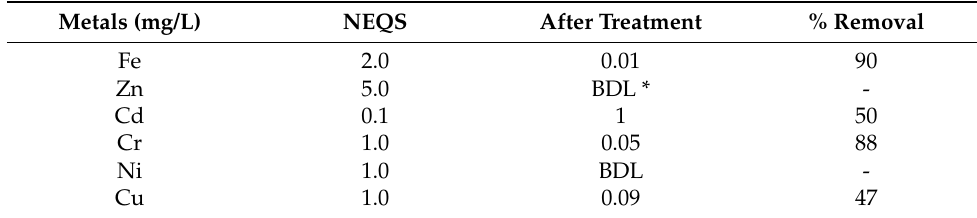
Table 3. Heavy Metals Removal by Wetland Filtration and catalytic